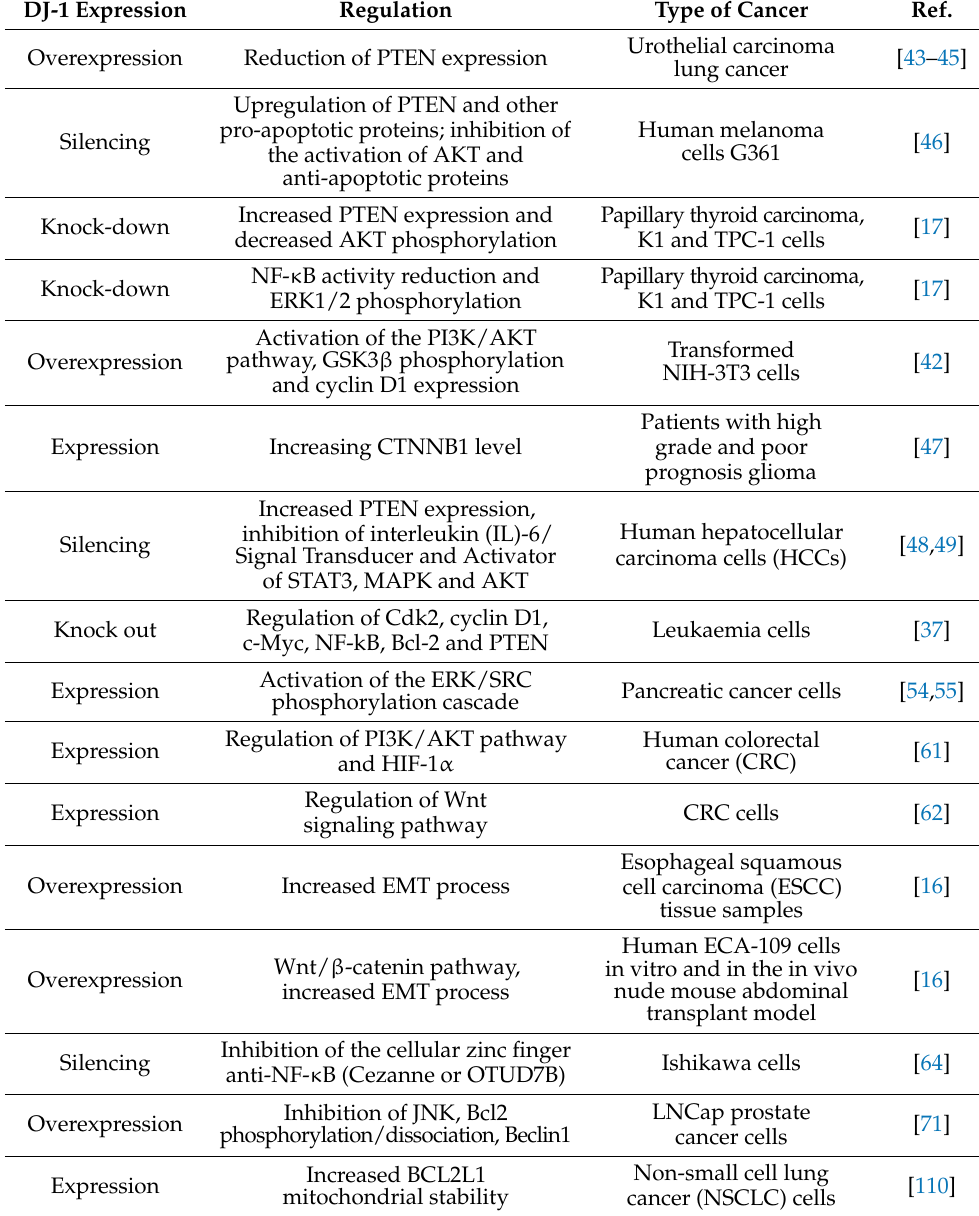
Table 1. Correlating the expression and the regulation of DJ-1 with different types of